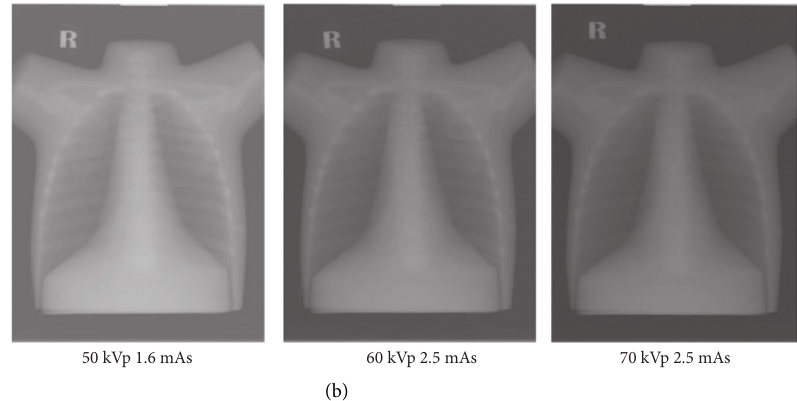
Figure 3: The resulting absorbed dose (mean ± SD) and the average visual grading analysis scoring (VGA) as a function of each exposure technique (a) Example of images in different image qualities obtained at different kV-mAs settings.